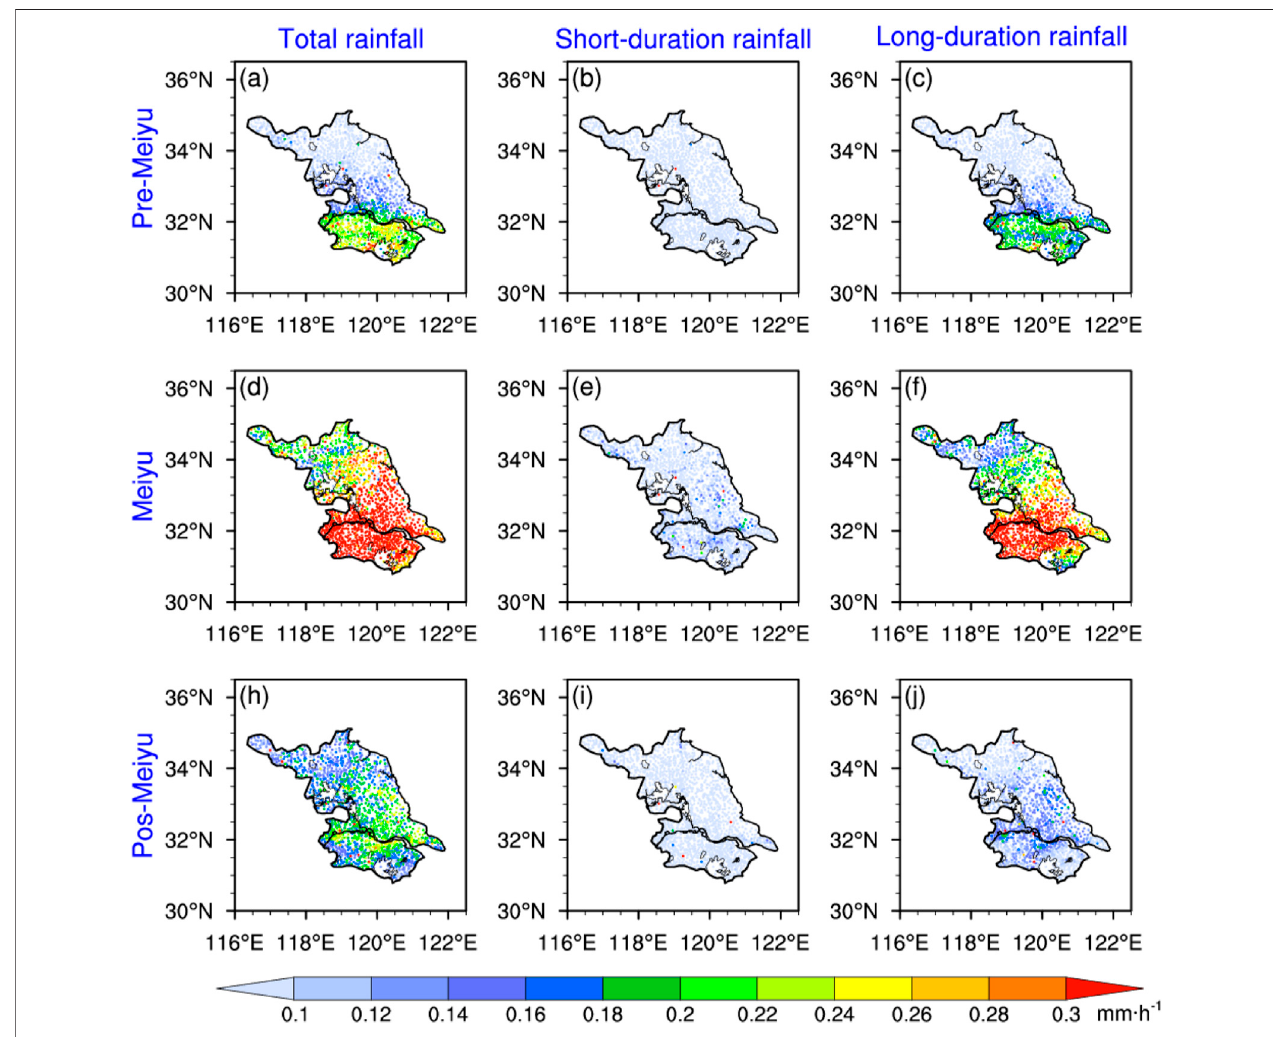
FIGURE 3 | Spatial distributions of PA for the total rainfall (A,D,H) , short-duration rainfall (B,E,I) and long-duration rainfall (C,F,J) in each sub-period of warm season (three rows separately represent Pre-Meiyu, Meiyu and Post-Meiyu period) averaged over 2013 – 2017.